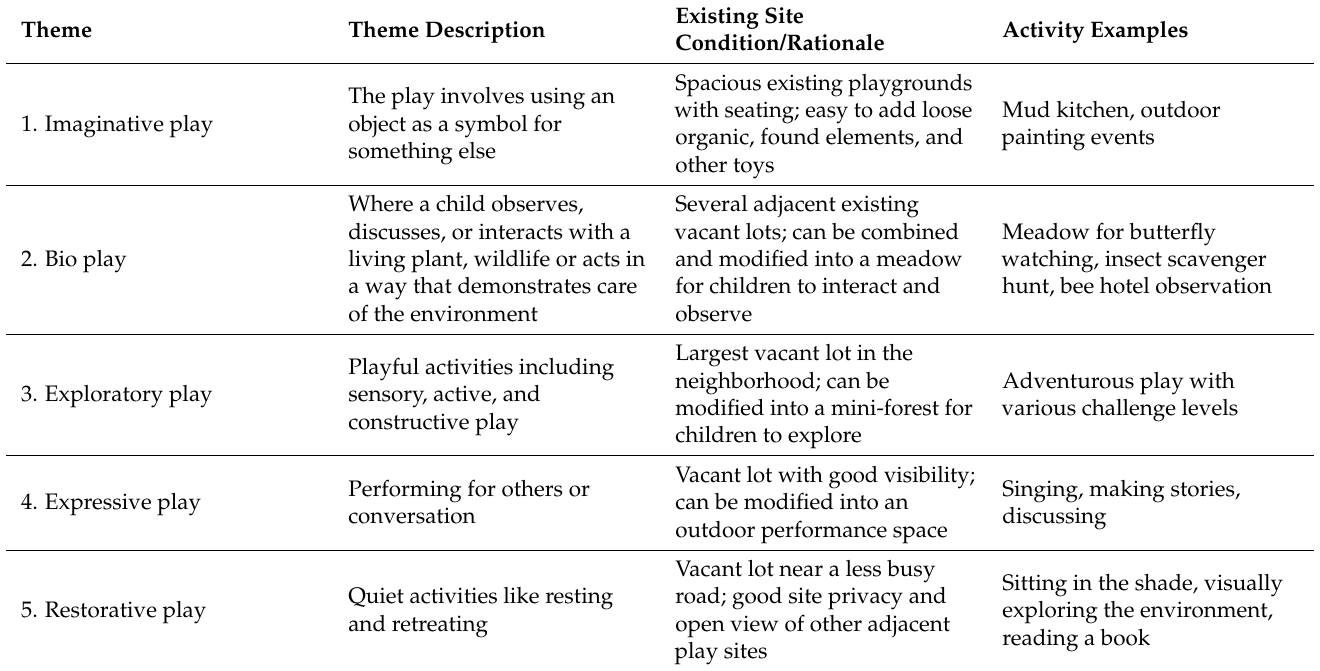
Figure 8. Play network and themes. Table 2. Play themes for each site (adapted from Loebach & Cox, 2020).